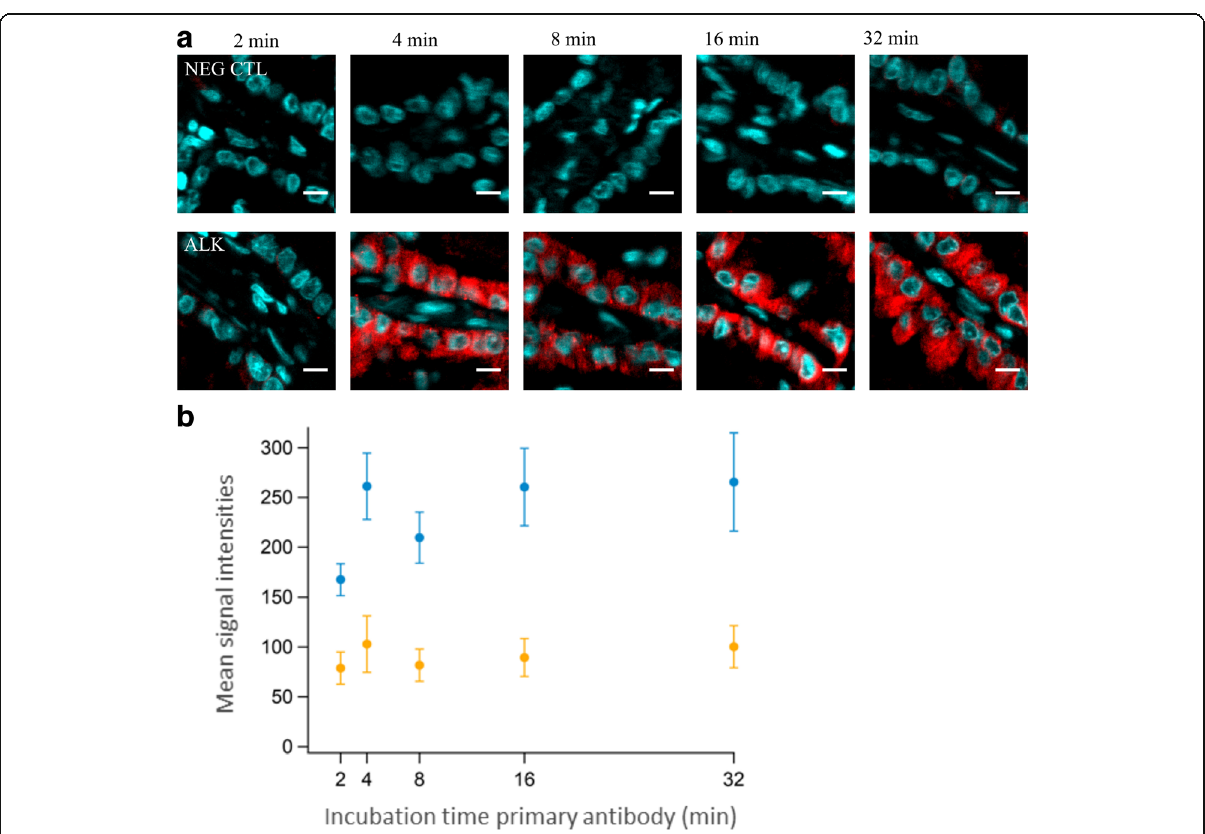
Fig. 2 Determination of optimal ALK primary antibody incubation time. a Tissue cuts (Case N°12) were incubated for 2, 4, 8, 16, or 32 min either with PBST 0.05% (CTL NEG, first row) or the anti-human ALK antibody (ALK, second row). The incubation time of the secondary antibody was kept constant at 8 min. The same region of interest (ROI) is presented for ALK IF and its negative control. Scale bar is 10 μ m. b Quantification of the ALK stained slides shown in ( a ). For each incubation time, 25 ROIs were manually placed in areas of ALK+ tumor epithelia and in areas of stroma only. The graph shows the average of the mean intensities of all 25 ROIs for ALK+ tumor epithelia (blue) and stroma (orange) with corresponding standard